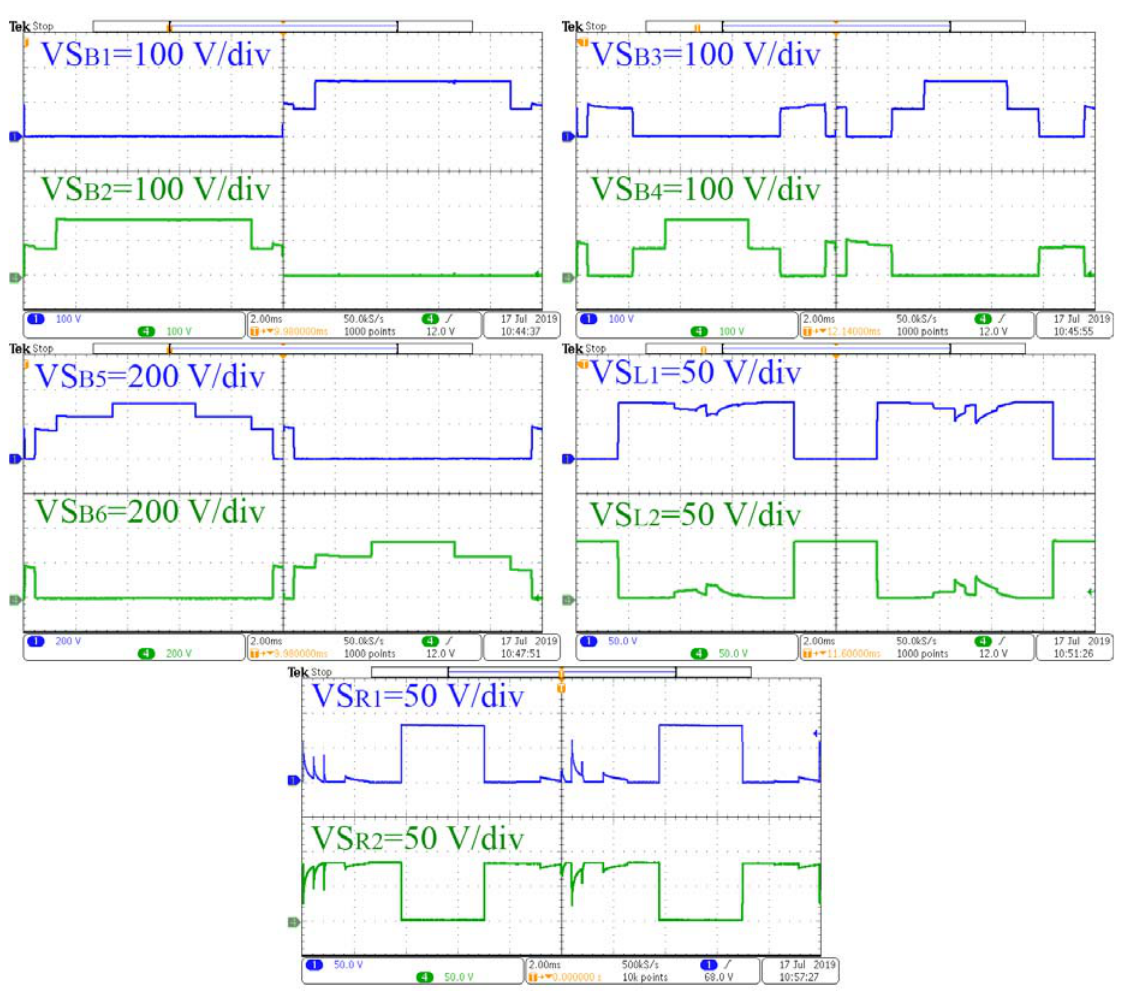
Figure 16. Experimentally measured blocking voltages across all